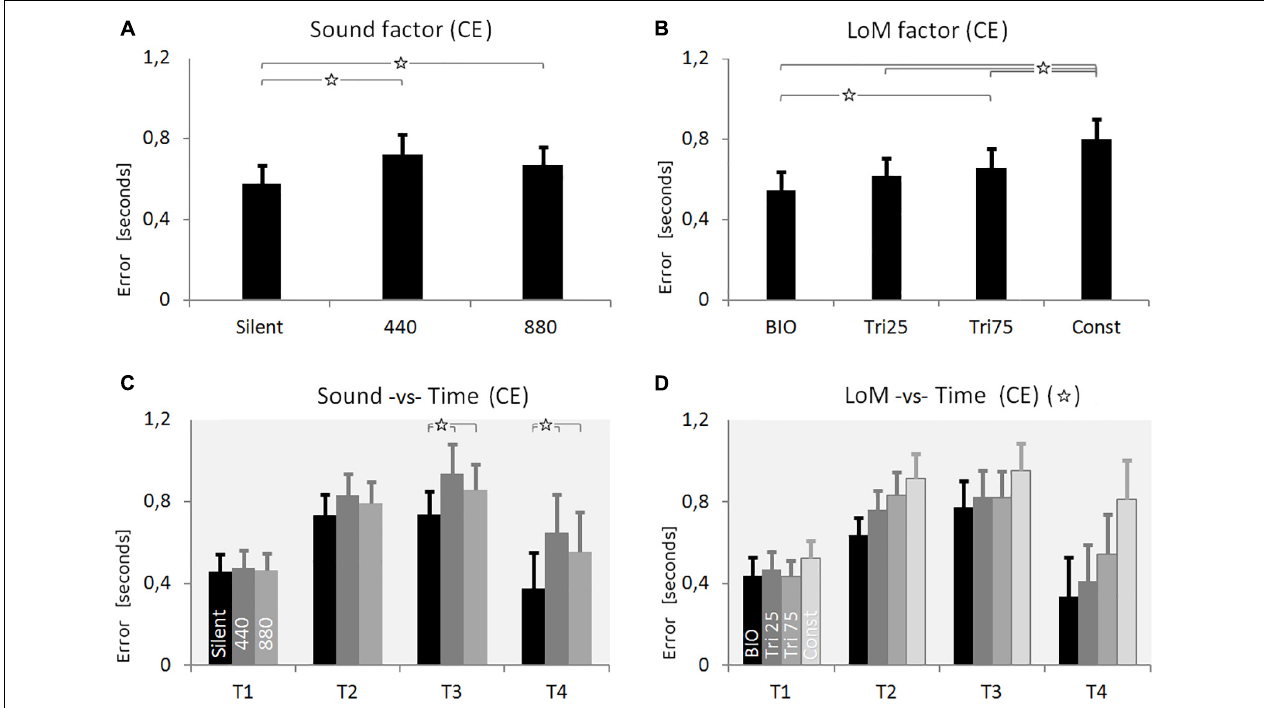
FIGURE 3 | Results of Experiment 1. (A) Constant Error (CE) for the three Sound conditions: Silent, constant frequency at 440 Hz, constant frequency at 880 Hz (pitch envelopes are presented in Figure 2 and described in the text). (B) CE for the four Laws of Motion (LoM): Biological velocity profile (BIO), Triangular velocity profile with a peak of velocity at 25% of the trajectory (Tri25), Triangular profile with a peak at 75% (Tri75), Constant velocity profile (Const). (C) Interaction between Sound and Time main factors. Each group of bars refers to a different Time condition (T1 = 0.5 s, T2 = 1.0 s, T3 = 1.5 s, T4 = 3.0 s); in each group, bars respectively presents the CE value of the three Sound conditions: Silent, 440, 880 (respectively in black, dark-gray, and light-gray color). Sound characteristics and statistical significances are described in the text. (D) Interaction between LoM and Time main factors. For each Time conditions (T1 = 0.5 s, T2 = 1.0, T3 = 1.5, T4 = 3.0) bars represent the CE of the LoM conditions (from the black to the light-gray bar, respectively: BIO, Tri25, Tri75, Const). Statistical significances are described in the text. For all charts: Y -values are in seconds, error bars represent standard errors of the mean, and stars indicate significant statistical differences (when the star is in the headline, please refer to the text for details regarding the statistical differences between